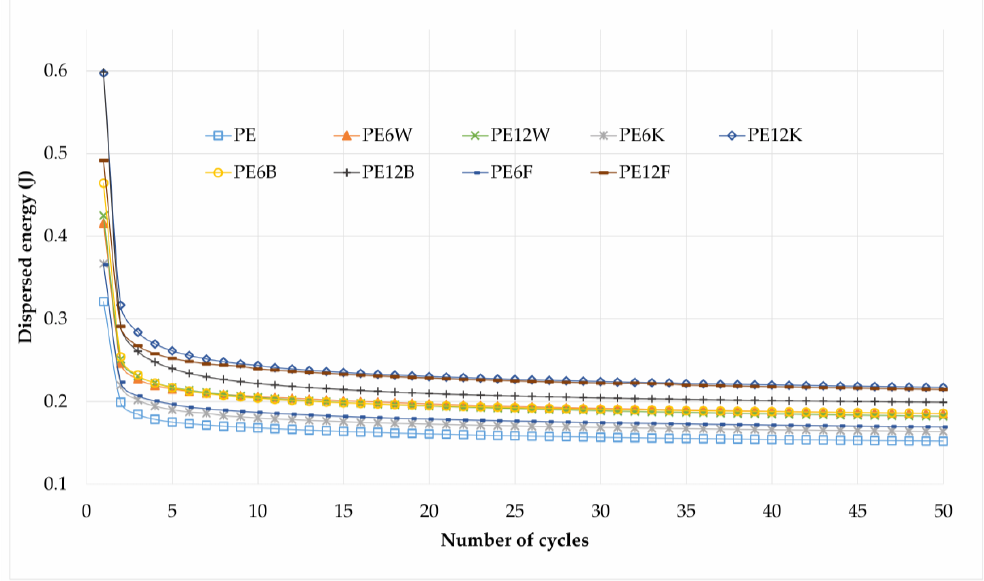
Figure 5. Comparison of flexural modulus of tested material.